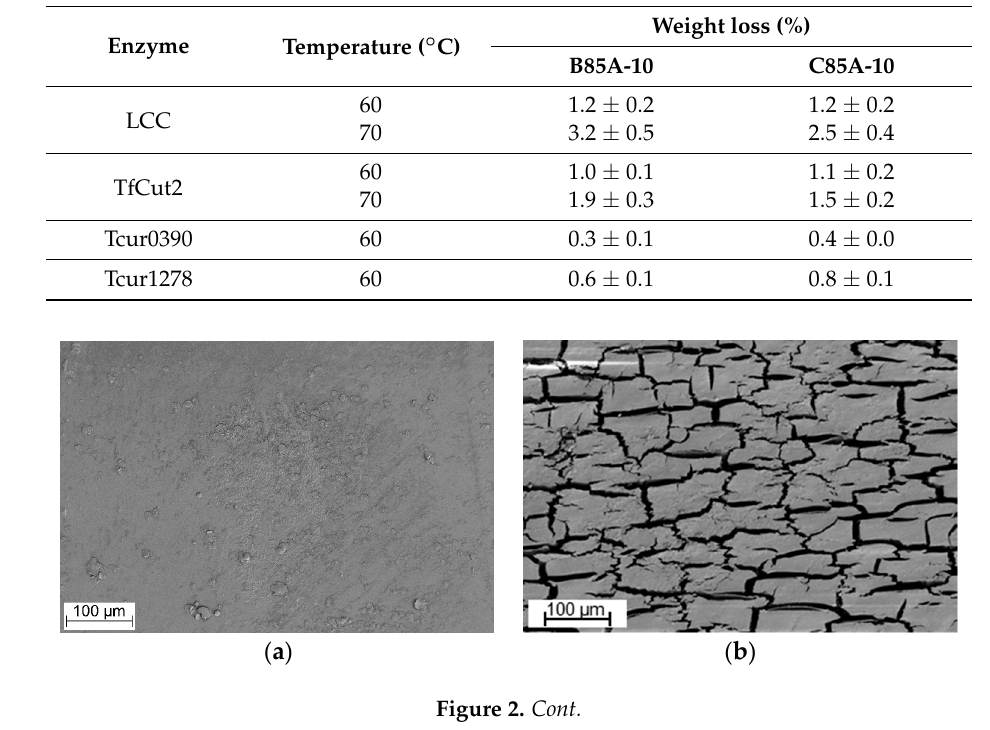
Table 2. Weight loss of TPU Elastollan B85A-10 and C85A-10 cubes with an initial weight of approximately 80 mg after hydrolysis by LCC, TfCut2, Tcur0390 and Tcur1278 for 100 h at 60–70 ◦ C. All values were determined at least in triplicate.